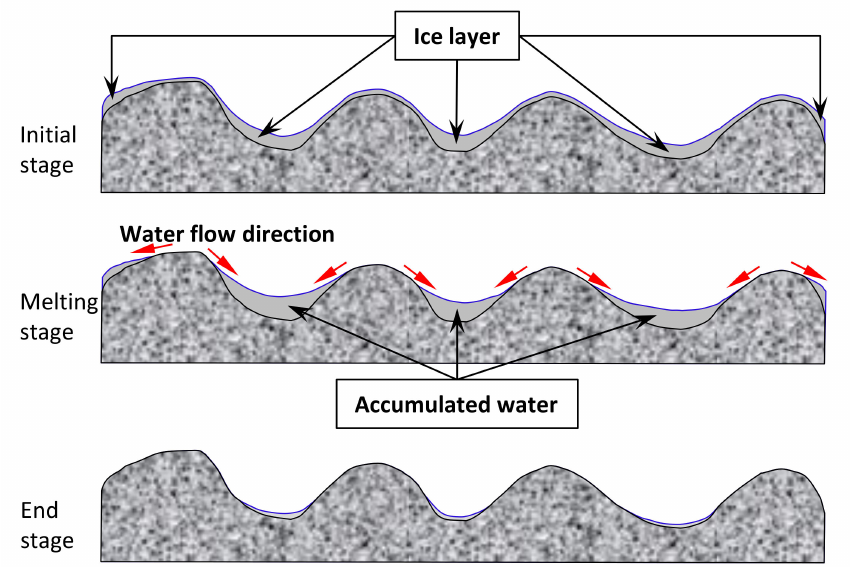
Figure 8. Graphic explanation on the macrotexture changes during ice melting process.